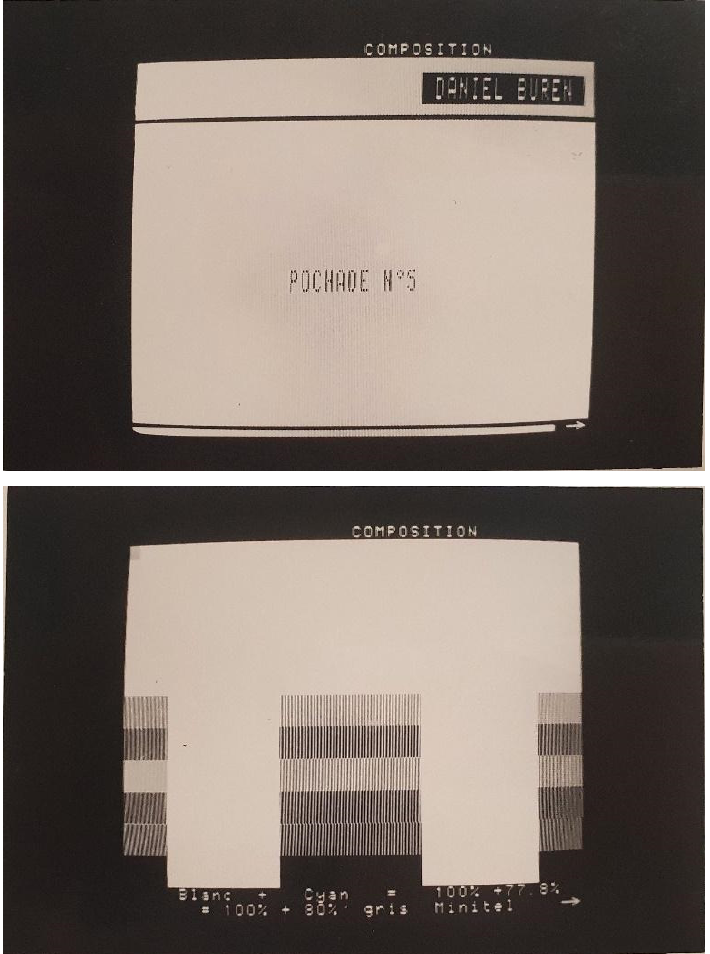
Figure 4. Images from “Pochade no. 5”, project by the artist Daniel Buren for Art Accès . Collection Frédéric Develay © Kandinsky Library, MNAM/CCI, Centre Pompidou.